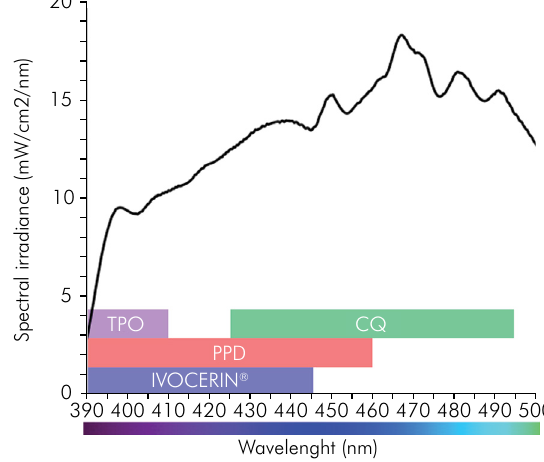
Figure 19. Spectral emission profile of a typical PAC light with absorption wavelength ranges for typical